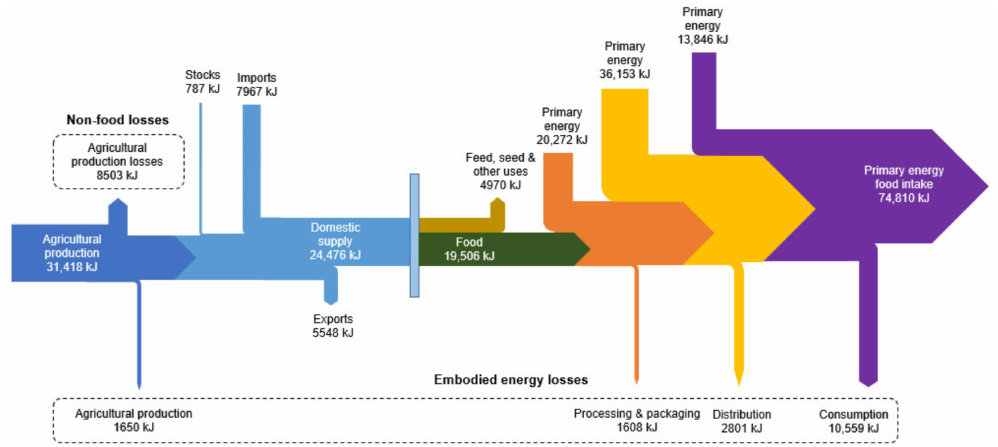
Figure 4. Sankey diagram for primary energy demand of the different food categories throughout the food supply chain. Values expressed in kilojoules per capita per